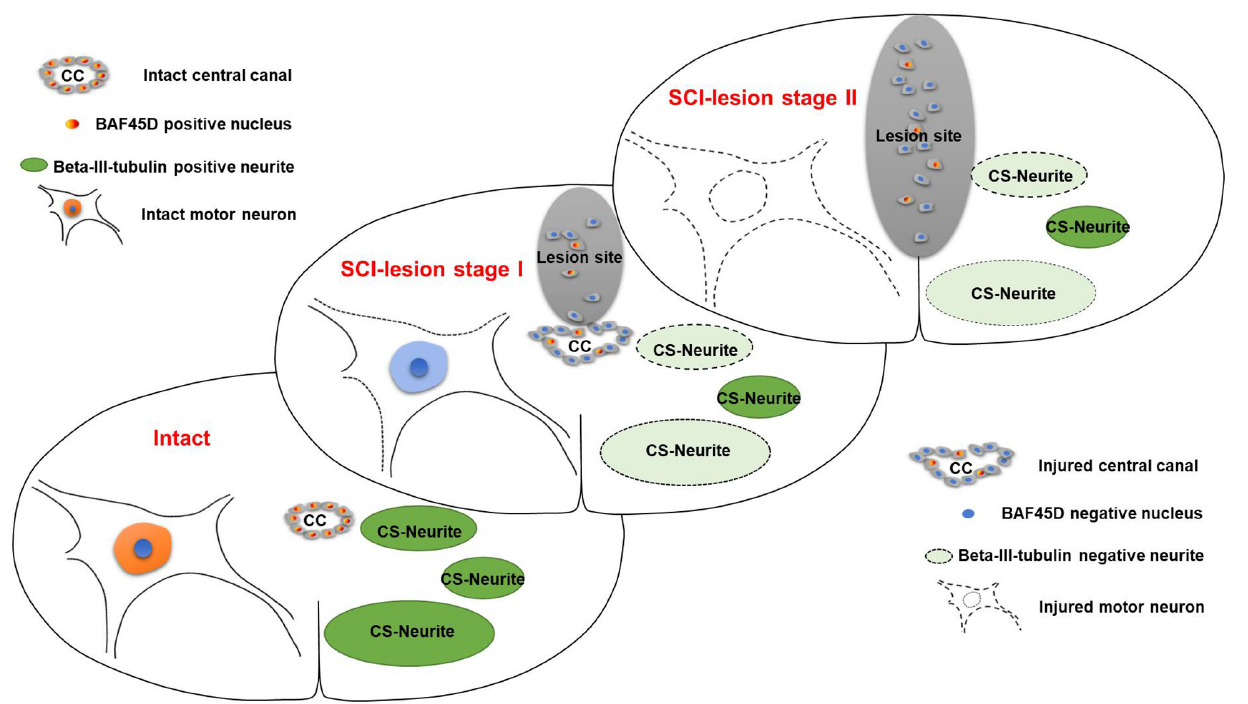
FIGURE 9 | Schematic representation of the relationship between SCECs and neuronal lesions following SCI in adult rats. SCI-lesion stage I indicates the time point at which the CC became disorganized but the circular distribution of SCECs was retained. At this timepoint, the loss of motor neurons was moderate but there was a significant reduction in the number of neurites. SCI-lesion stage II indicates the time point at which there was a complete loss of SCEC organization together with a further loss of motor neurons, but not neurites, as compared with stage I. This suggests that SCECs protect SCI-lesions and that the loss of such protection accelerates the development of neuronal lesions. Moreover, the expression of BAF45D was downregulated in cells derived from SCECs, which proliferate and migrate to non-neural lesions during this